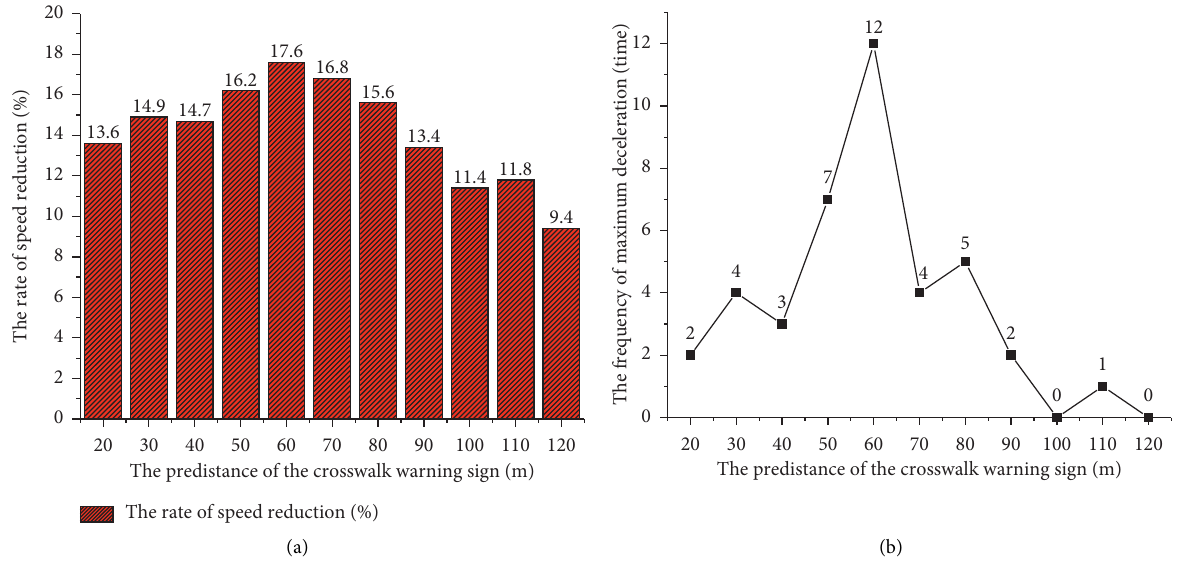
Figure 6: The rate of speed reduction and times of maximum deceleration at a design speed of 50km/h. (a) The rate of speed reduction. (b) The frequency of maximum deceleration.